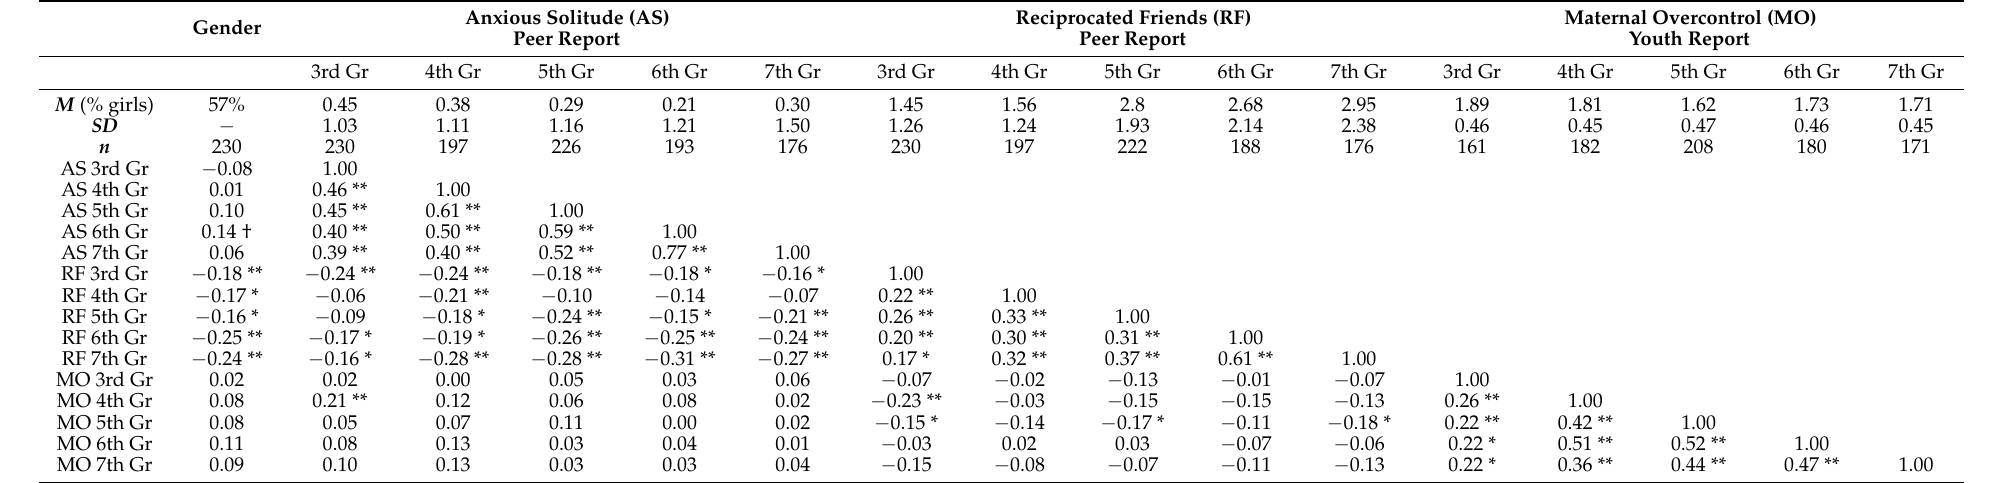
Table 2. Means, standard deviations, sample size, and Pearson intercorrelations for all study variables from third through seventh